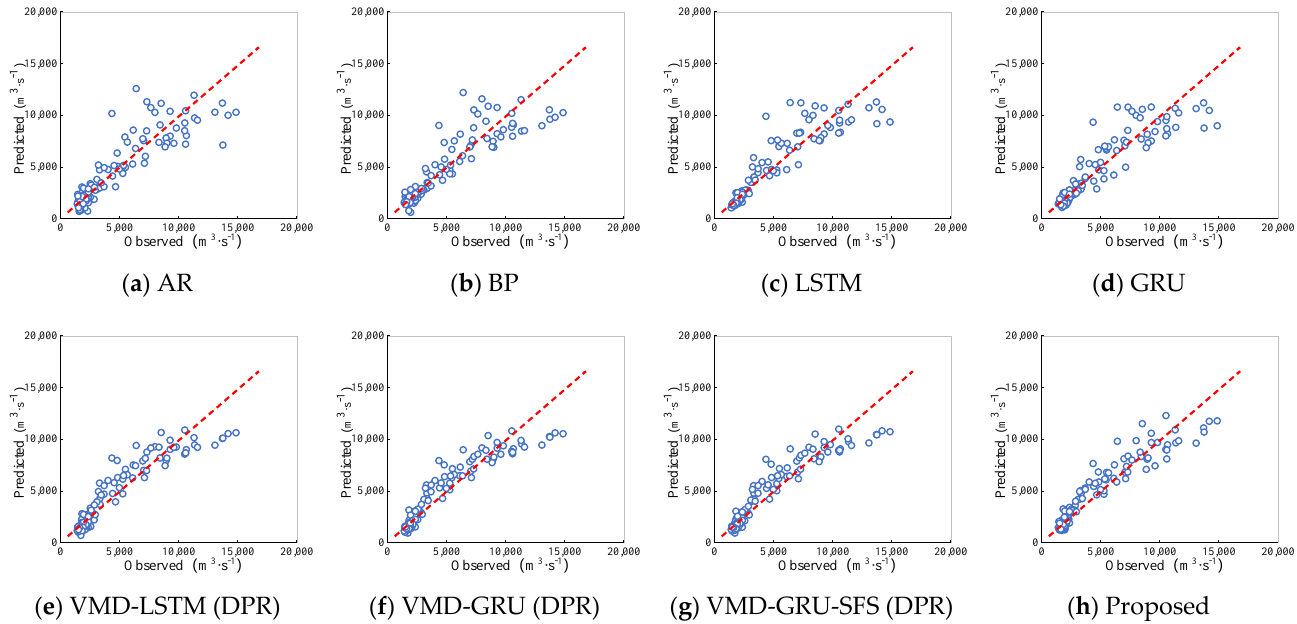
Figure 7. Scatter plots of different methods for the Pingshan station. ( a ) AR model; ( b ) BP model; ( c ) LSTM model; ( d ) GRU model; ( e ) VMD-LSTM (DPR) model; ( f ) VMD-GRU (DPR) model; ( g ) VMD-GRU-SFS (DPR) model; ( h ) Proposed model.